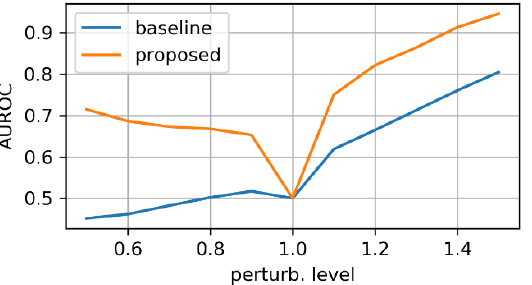
Figure 7. AuRoC performance for the baseline and proposed architecture when tested against mask zooming. Training done only on original data.